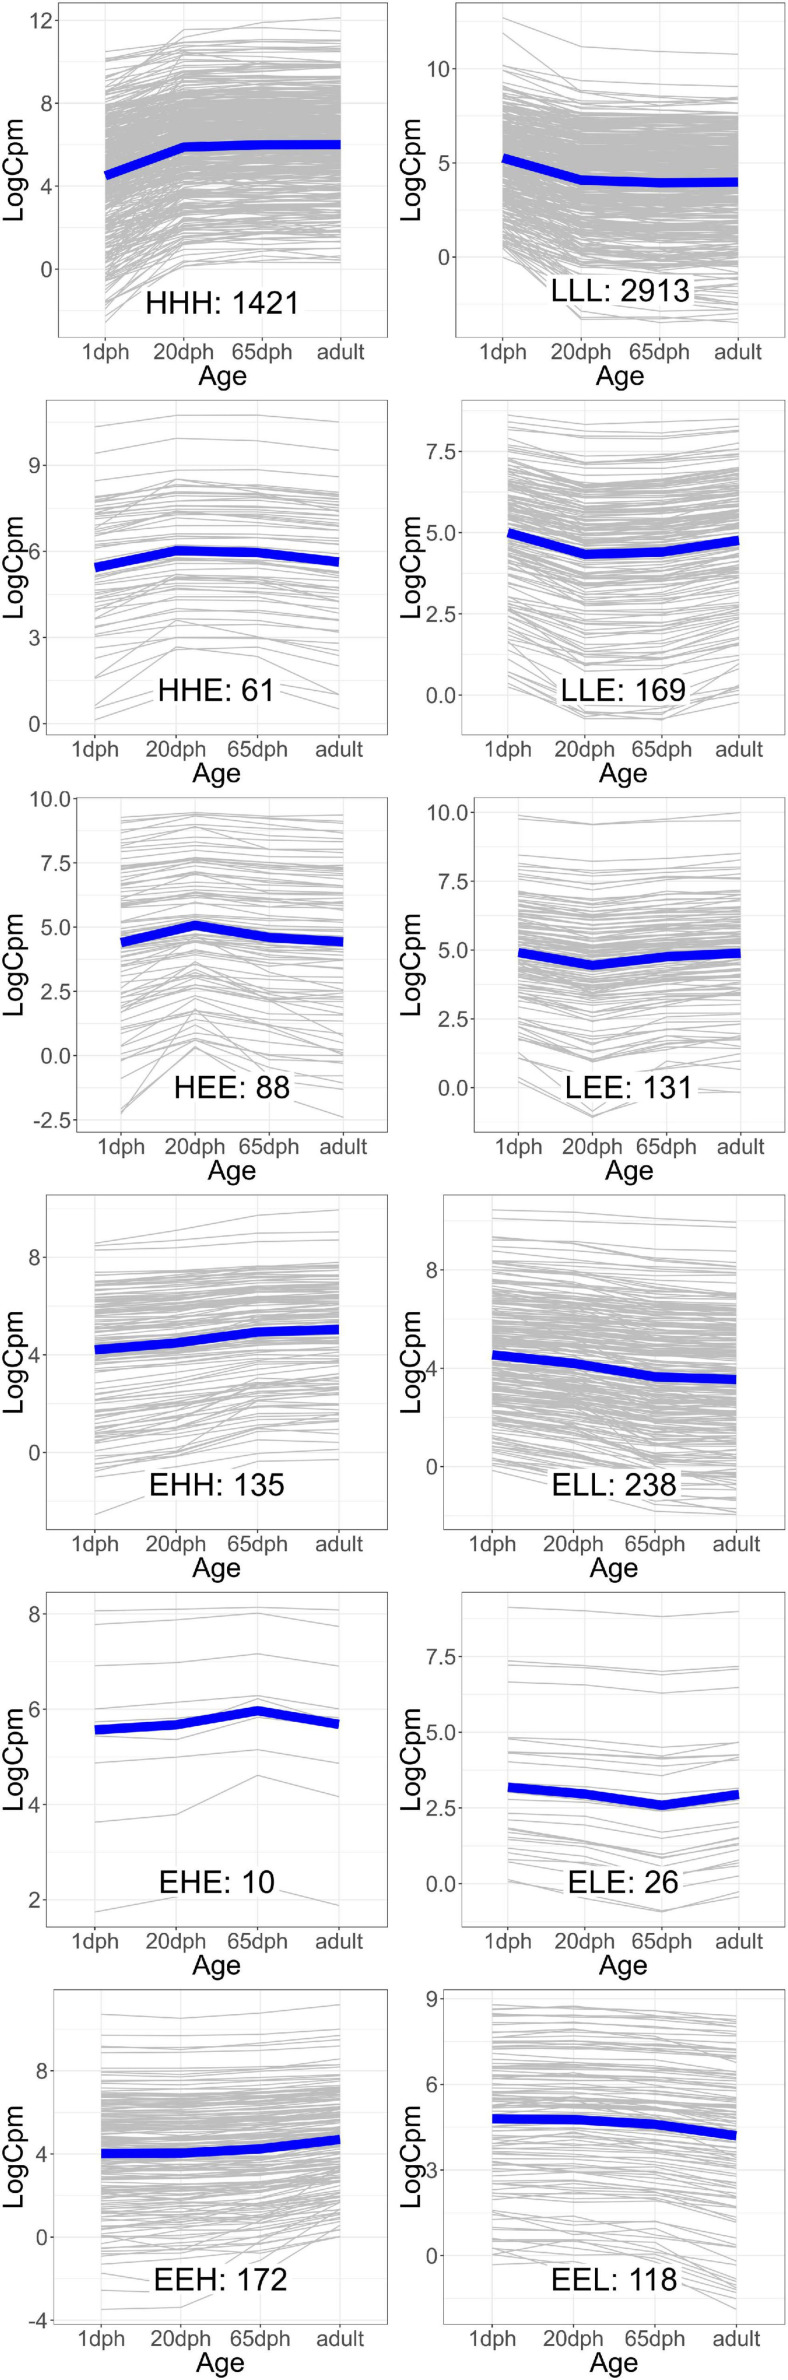
Groups of genes with similar gene expression patterns over the four time points. The expression of each individual gene [in counts per million reads mapped (cpm)] is plotted in gray, while the blue line indicates the average trend. The number of genes in each group is indicated. Group names reflect the relative expression at each time point [20 and 65 days post hatch (dph) and adult] compared with 1 dph, with H, higher, E, equal, and L, lower.